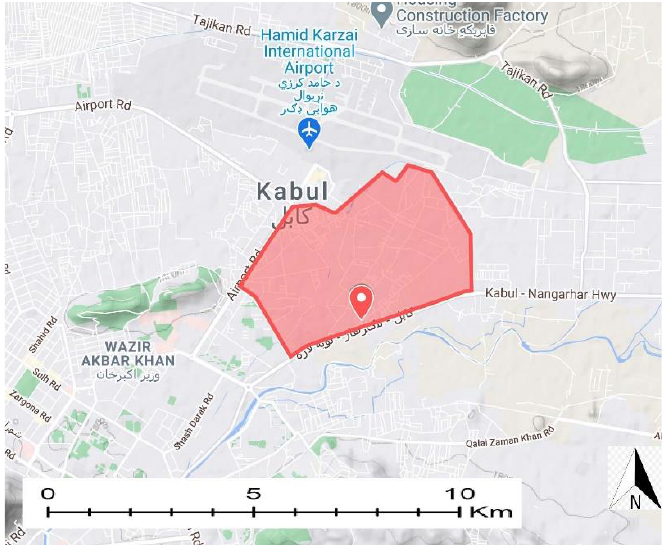
Figure 1. The location of Yakatoot Municipal area in Kabul